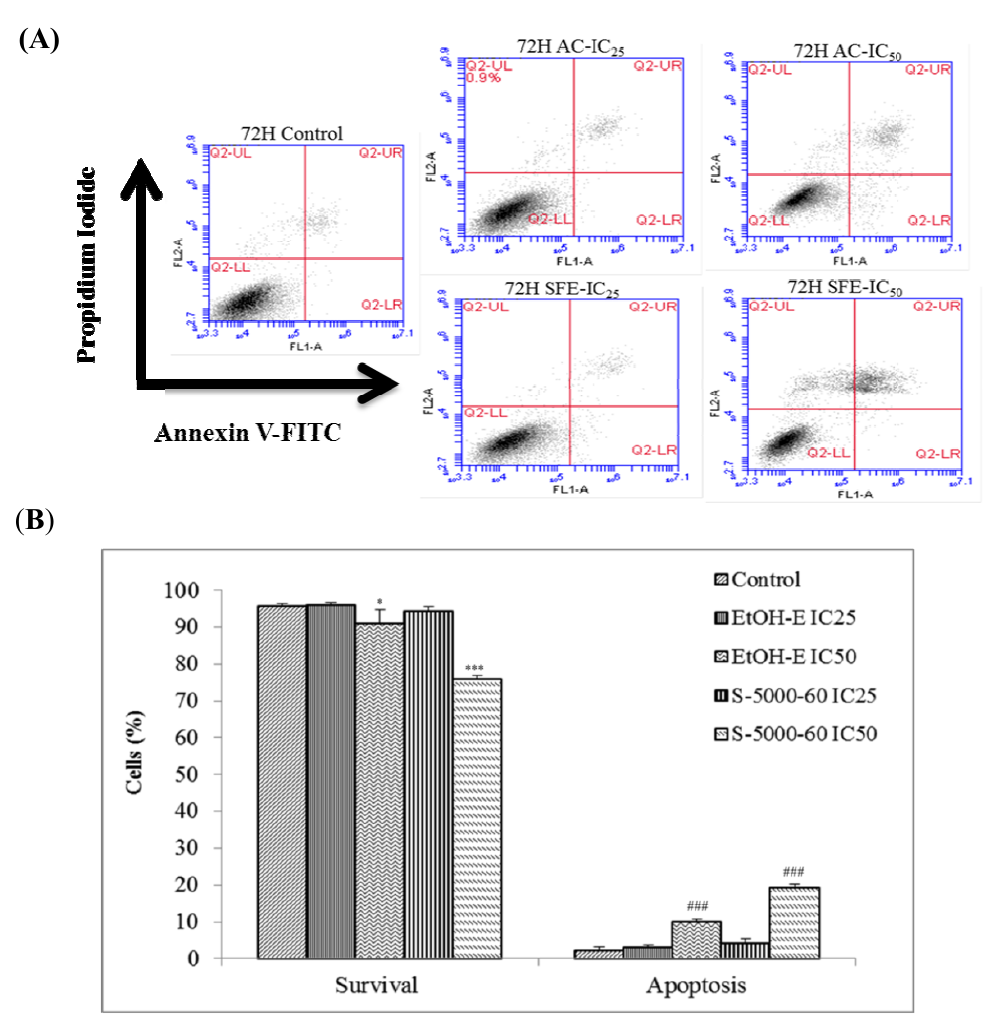
Figure 5. The effects of S-5000-60 and EtOH-E extracts on apoptosis induction in HepG2 cell. Representative dot-plots ( A ) and the percentages of apoptosis in HepG2 cells; ( B ) from three independent experiments for the quantitative assessment of apoptosis induction by using Annexin V and PI staining after treatment with extracts at 72 h. The total percentage of viable cells, cells undergoing apoptosis, apoptotic cells, and necrosis cells is taken as 100%. Values are the mean ± SD of three independent experiments. * p < 0.05 vs. Control; *** p < 0.001; ### p <